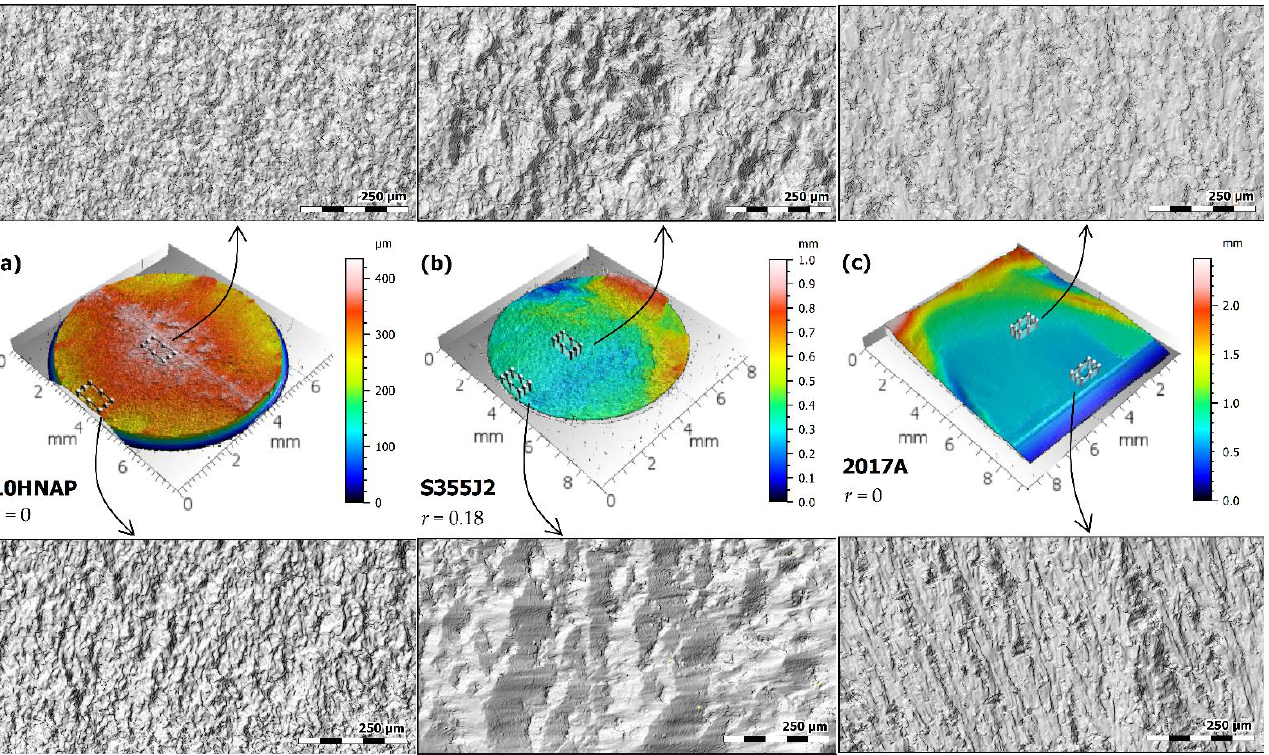
Figure 7. Exemplary fractures with marked spots of crack propagation of three analysed grades of specimens: ( a ) 10HNAP steel, ( b ) S355J2 steel, ( c ) 2017A-T4 aluminium alloy. Table 2. Exemplary fractures fractal dimension Df results for entire fracture and areas of crack initiation and propagation of three analysed types of specimens. Specimen Entire Fracture